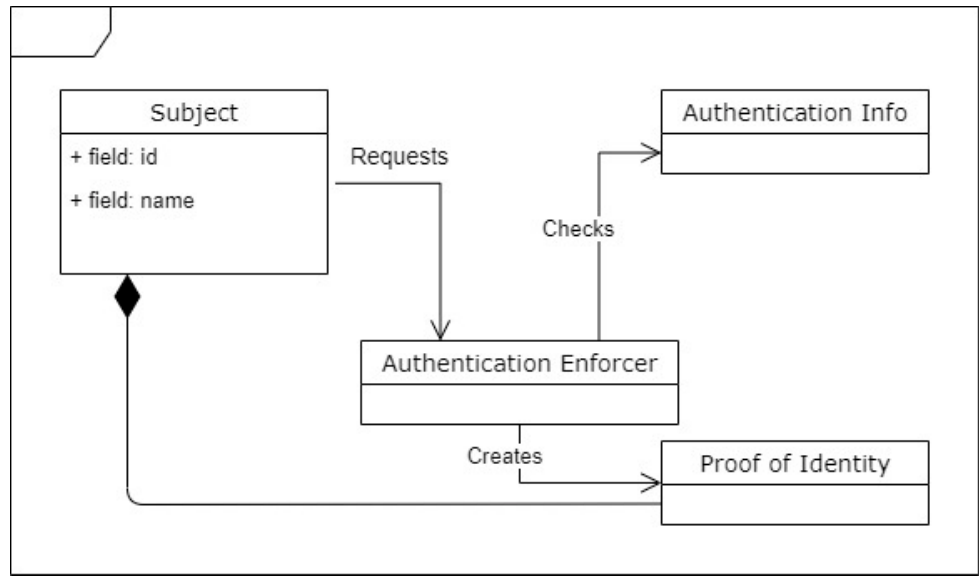
Figure 16. Essential components of Authentication Enforcer pattern—class diagram [14].